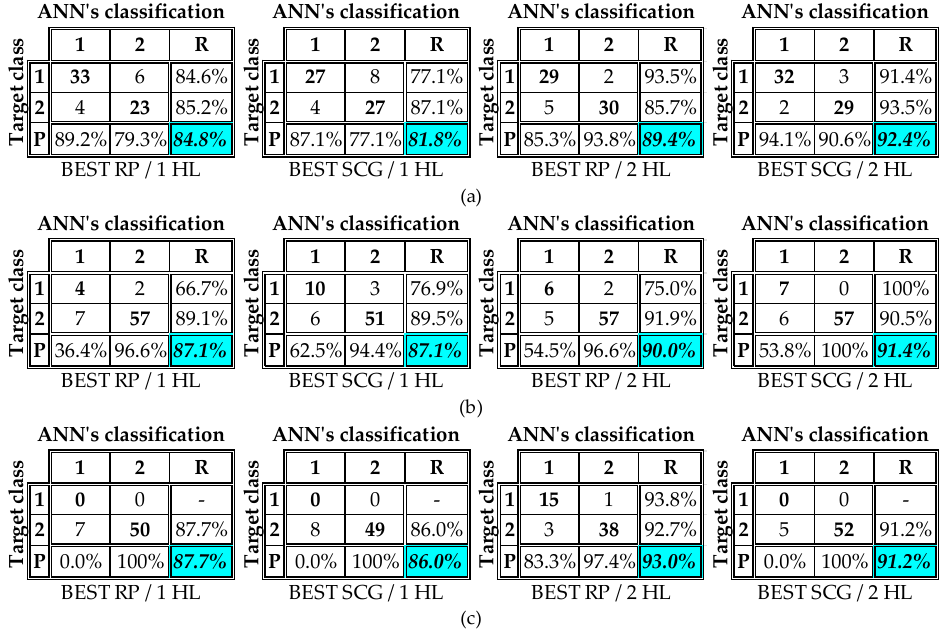
Figure 11. Maximum OA index values extracted by NA2C2M networks with 1 or 2 hidden layers: ( a ) BB; ( b ) RIB; ( c ) IIB. In order to more robustly confirm the advantage of networks with two hidden layers, the CMs corresponding to the optimally configured networks with one and two hidden layers (Figure 11), on the basis of the testing subsets, are presented in Figure 12.